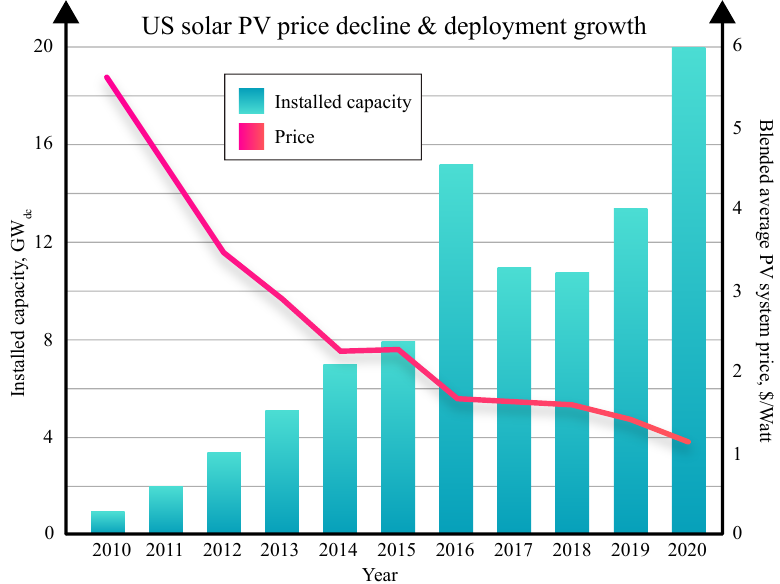
Figure 25. Exponential cost reduction with the increased installed solar capacity. The phenomenon can be explained through Swanson’s law, which establishes a relation between cost reduction and global manufacturing capacity